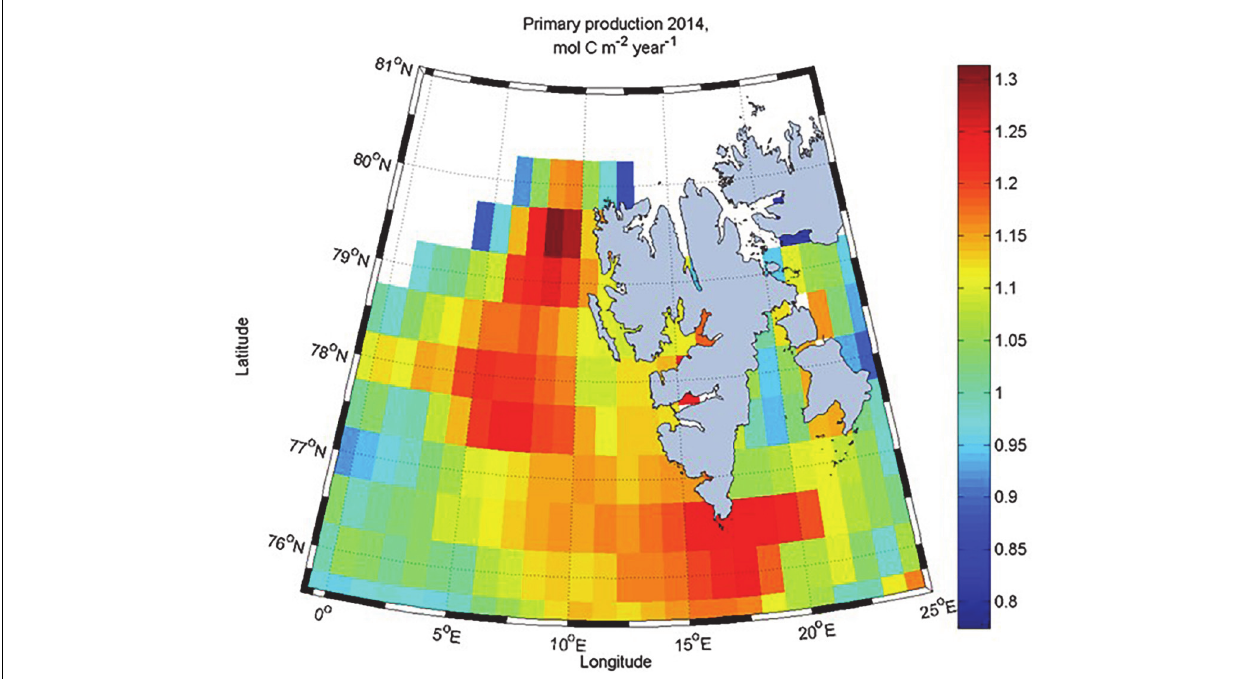
FIGURE 14 | Remotely sensed net primary production (NCP sat , mol C m − 2 ) for 2014 from the Vertically Generalized Production Model (VGPM, Behrenfeld and Falkowski, 1997) downloaded from www.science.oregonstate.edu. NCP sat was estimated by integrating the production time series from each grid cell throughout the productive season (Børsheim et al.,